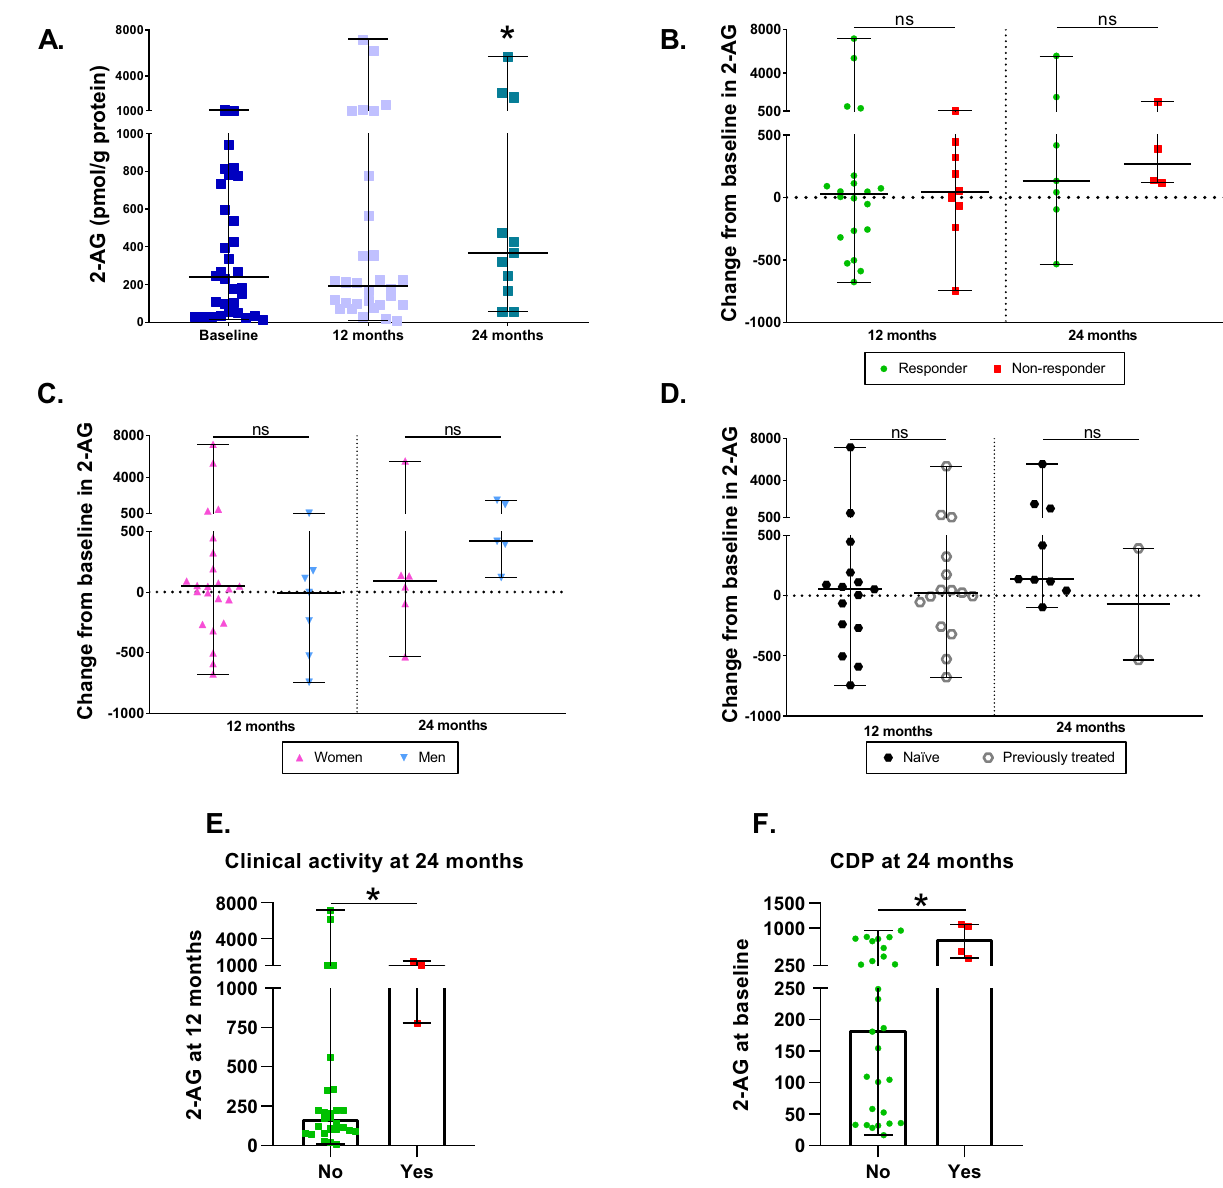
Figure 2. Characterization of 2-AG levels during DMF treatment. ( A ) 2-AG levels in MS patients at baseline and after 12 and 24 months of DMF treatment. ( B ) Changes in 2-AG levels at 12 and 24 months compared to baseline between responders and non-responders to DMF. ( C ) Changes in 2-AG levels at 12 and 24 months compared to baseline between women and men ( D ) Changes in 2-AG levels at 12 and 24 months compared to baseline between naïve and previously treated patients ( E ) 2-AG at 12 months in patients with (yes) or without (no) clinical activity at 24 months. ( F ) 2-AG at baseline in patients with (yes) or without (no) confirmed disease progression (CDP) at 24 months. The Wilcoxon test was used to compare differences between the different time points and baseline, and the Mann–Whitney test was used to compare differences between subgroups. Data are expressed as median with range in pmol/g of protein. *p < 0.05; ns, not